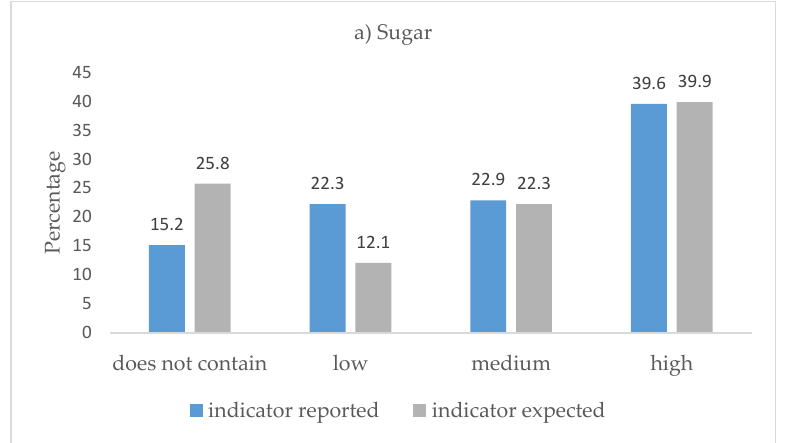
Table 4. Proportion of products with inconsistencies in the traffic light label and statement on sweeteners by category of